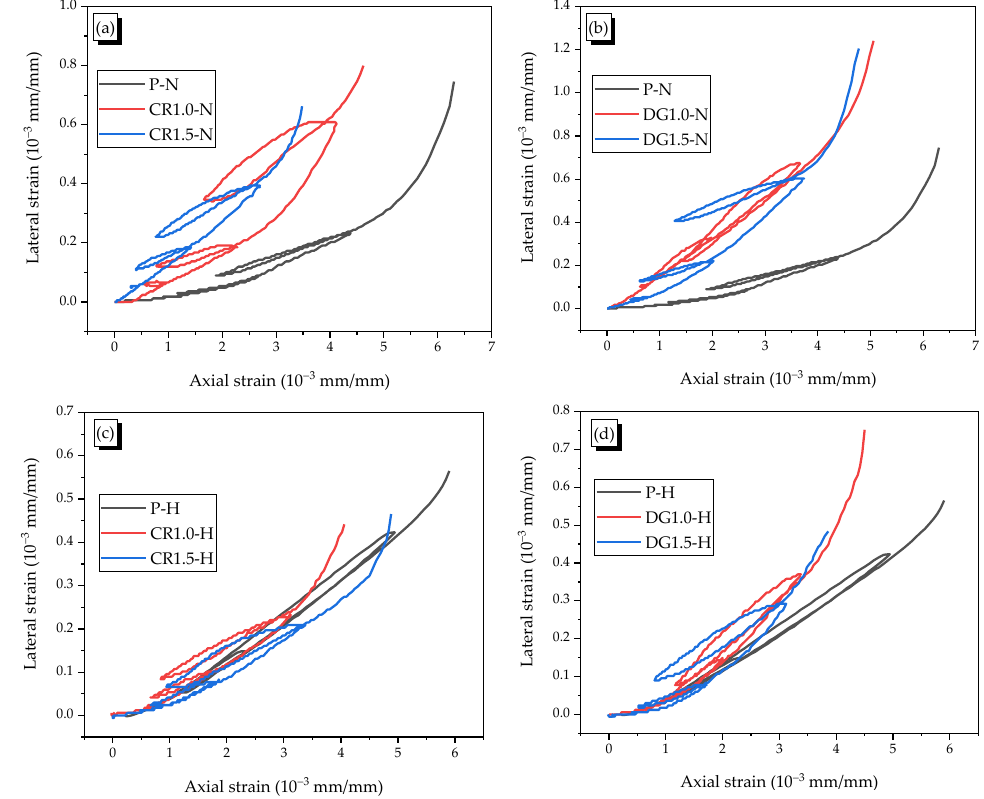
Figure 12. Typical axial–lateral strain curves ( a ) P-N and CR-N specimens, ( b ) P-N and DG-N specimens, ( c ) P-H and CR-H specimens, ( d ) P-H and DG-H specimens.